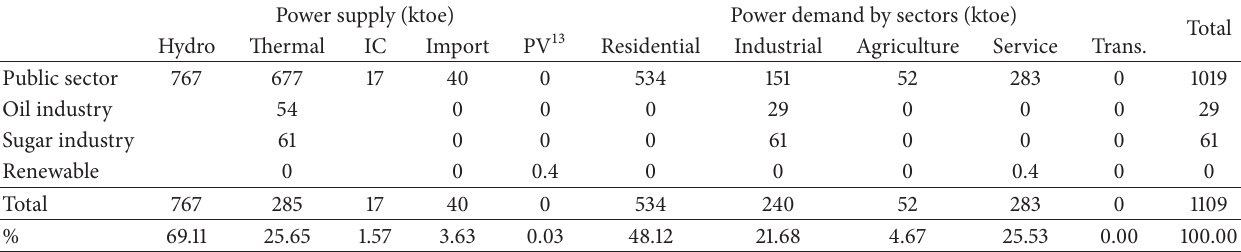
13 PV: photovoltaic.